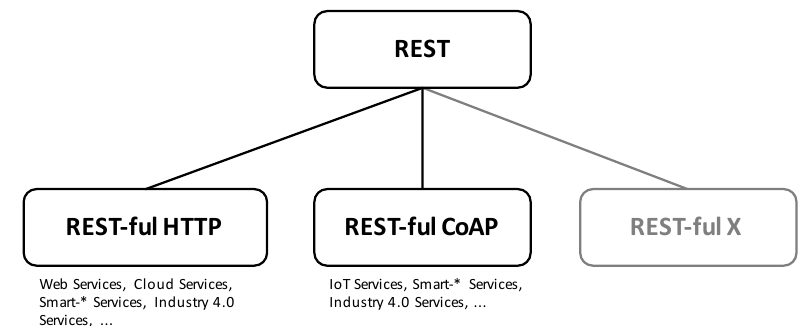
Figure 2. Instantiation of the general REST architecture style to specific REST-ful protocols.